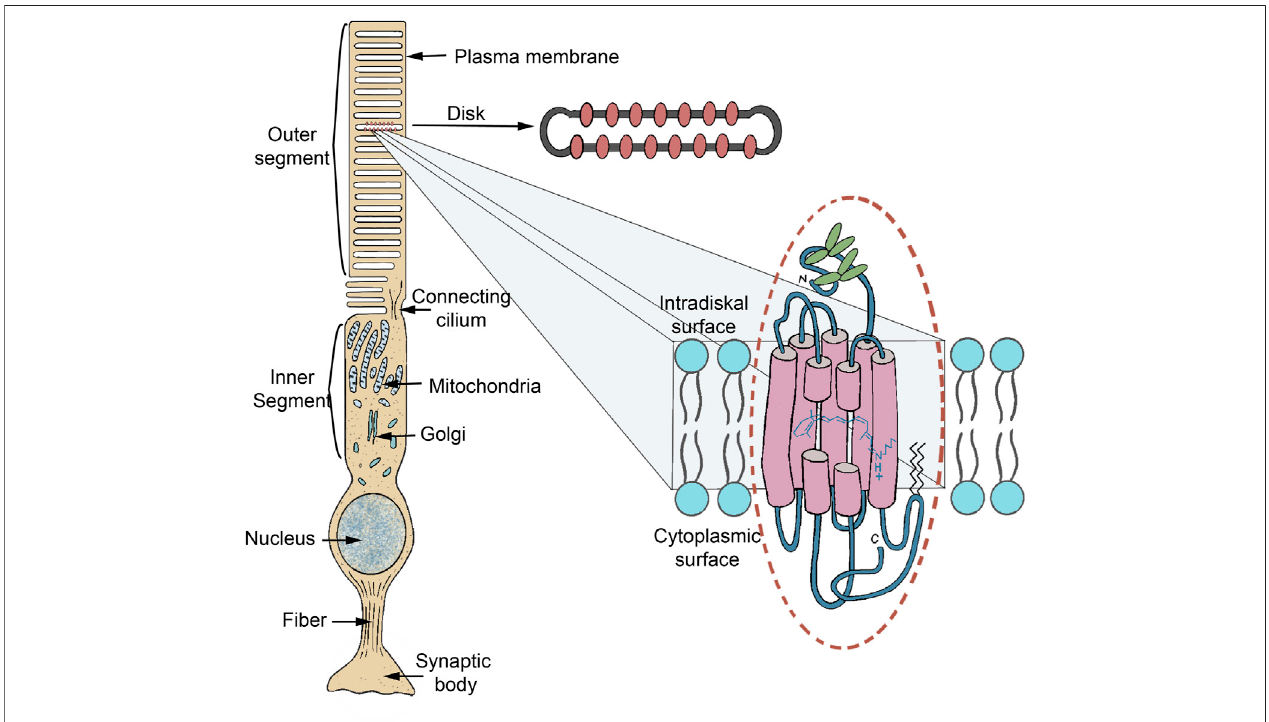
FIGURE 2 | Schematic of a vertebrate rod photoreceptor cell (scotopic vision), zooming in on the location of the rod visual pigment rhodopsin. The rod outer segment (ROS), a ciliary outgrowth, is densely fi lled with isolated fl attened vesicles (discs) which contain rhodopsin as the major (ca 90% w/w) membrane protein. The vertebratevisualpigmentsarethereforealsodesignatedas “ ciliaryrhodopsins. ” Otherdiscmembraneproteinsareinvolvedinsignalpropagation,stabilizationofthedisc shape and communication with the plasma membrane (PM). The phospholipids in the disc membrane have an exceptionally high content (ca 40%) of highly unsaturatedfattyacids(22:6 ∞ 3)(Daemen,1973).ThediscsarecontinuouslygeneratedatthebaseoftheROSasinvaginationsofthePM,thenarenippedoffandmove upwards.After7 – 10 daystheyreachthetopoftheROS,whichispinchedoffinacircadianrhythmanddegradedintheadjacentretinalpigmentepithelium(RPE)(Young, 1976). The vertebrate cone photoreceptor (photopic vision) is organized in a similar fashion, except that the “ discs ” remain continuous with the PM as invaginations and are not pinched off. The organization of invertebrate visual photoreceptors is roughly similar, but the photoreceptive membranes are organized as numerous microvilli in rhabdomeric structures (Warrant and McIintyre, 1993) and their rhodopsins are also designated as rhabdomeric visual pigments. Only the classical visual pigments (Opn1, Opn2 and R-gene families) are organized in these specialized cellular outgrowths. All other type-2 and all type-1 pigments are targeted to the PM or an eyespot and form only a small part (up to several percent) of that membrane protein population.